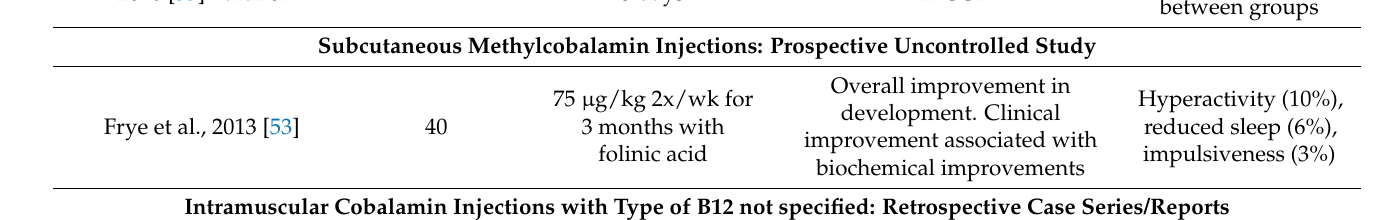
Table 4. Studies of cobalamin injections for autism spectrum disorder with clinical outcomes. Childhood autism rating scale (CARS); clinical global impression scale (CGI); subcutaneous (SC); years old (yo). Study Participants Treatment Outcomes Adverse Effects Subcutaneous Methylcobalamin Injections: Prospective Double-Blind Placebo Controlled Studies Bertoglio et